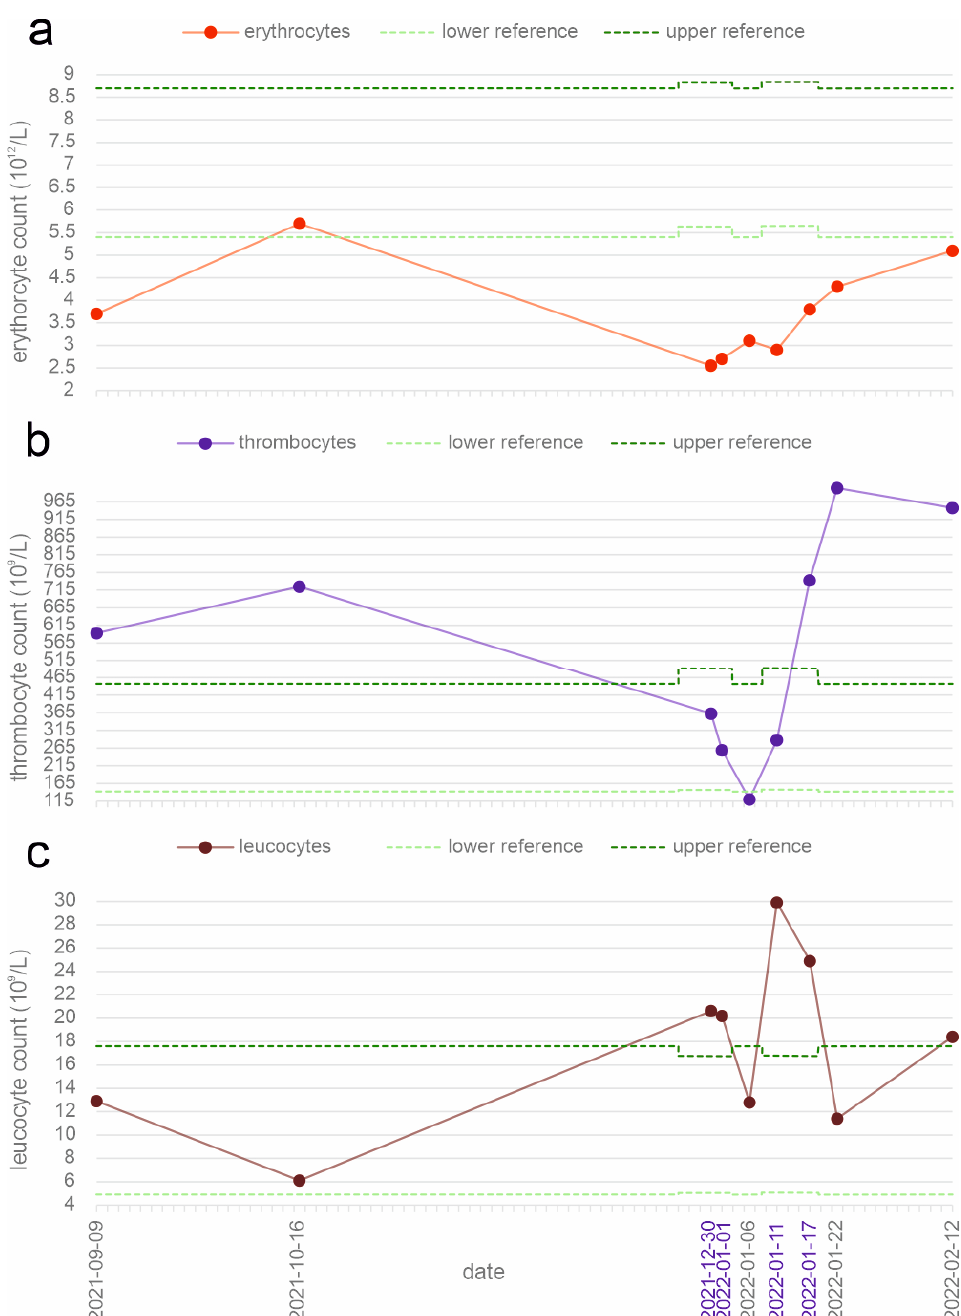
Figure 1. Erythrocyte counts ( a ), thrombocyte counts ( b ), and cell counts of leucocytes ( c ) at examined time points. Each point represents the measured value of each time point, and dotted lines represent reference values. Dates in blue are time points where measurement was performed with the ProCyte One ® Haematology Analyser (IDEXX, Vienna,